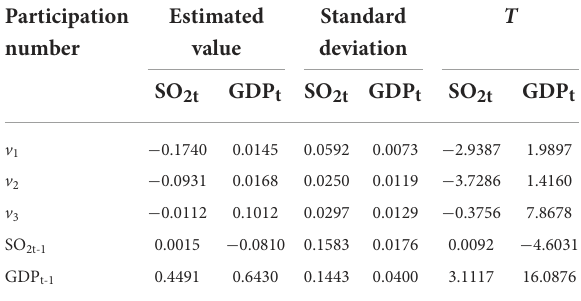
TABLE 1 Results of the MSIH (3)–VAR (1) model parameter